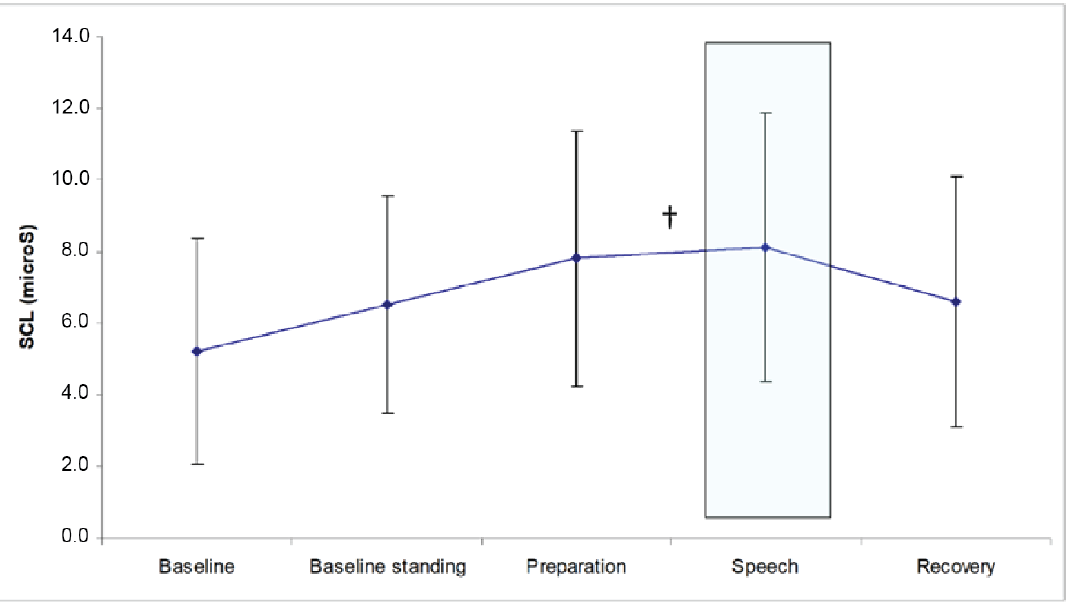
Figure 3. SCL in response to the public speaking task. † p < 0.10 Helmert contrast (change). Cortisol responses to the task were significant. The cortisol concentrations at the end of the pretask baseline were lower than the highest cortisol concentration measured during the 25 min after the speech (t 197 = 7.2, average increase: 2.3 nmol/L; average percentage increase: 143% above baseline value; see Figure 4). Importantly, no differences were found in cortisol AUC between low and high SAS-A